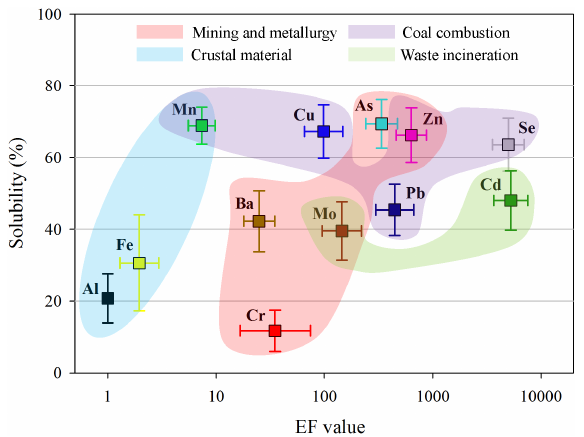
Figure 8. Scatter plot of aerosol element solubility versus the logarithmic EF value, computed with the geometric mean in the 99% confidence interval. Coloured shade areas represent different sources classified by EF value and PCA